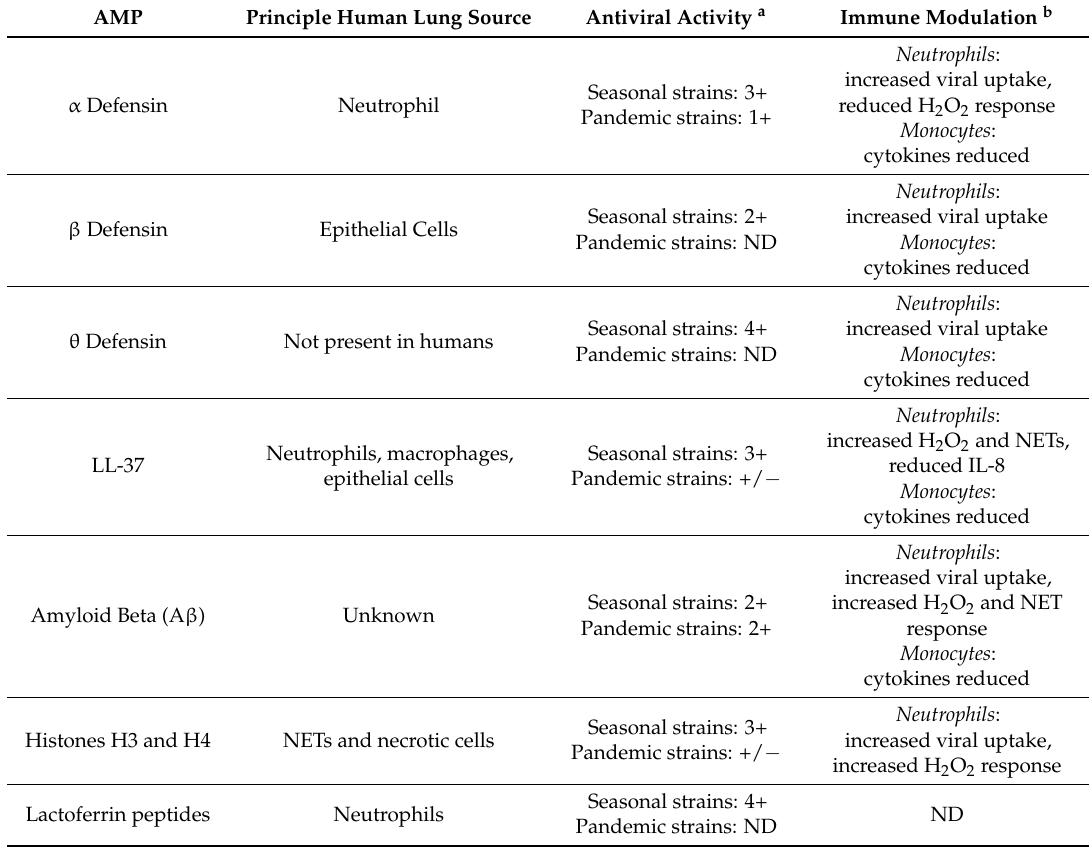
Table 1. Antiviral and immunomodulatory activity of AMPs with respect to